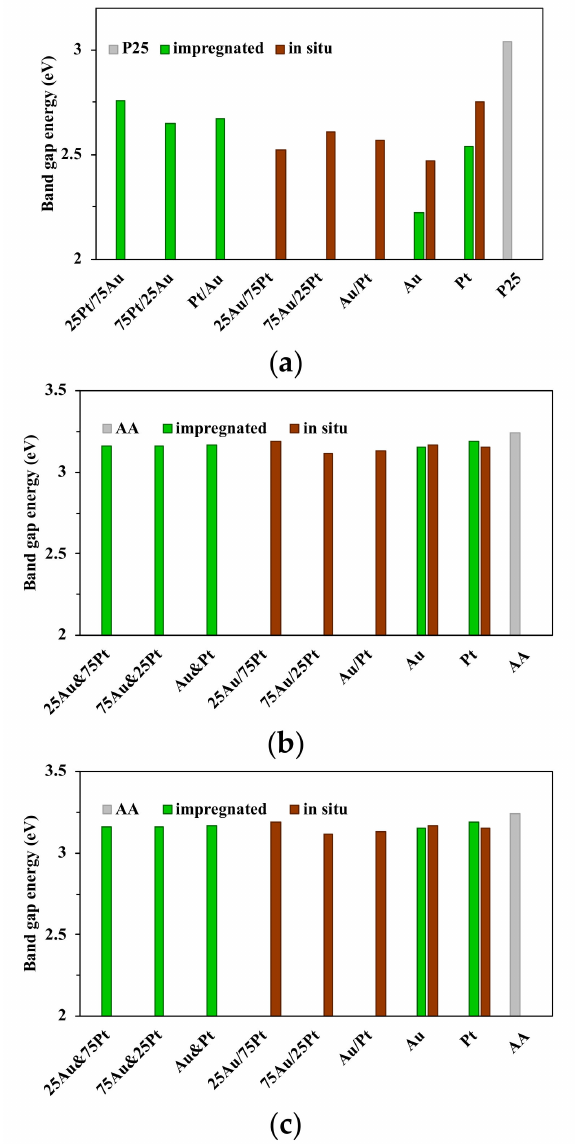
Figure 5. Comparison of the bandgap energy values of the composites based on the different titanias. ( a ) bandgap energies of the P25-based composites and P25, ( b ) bandgap energies of the AA-based composites and AA, ( c ) bandgap energies of the AR-based composites and